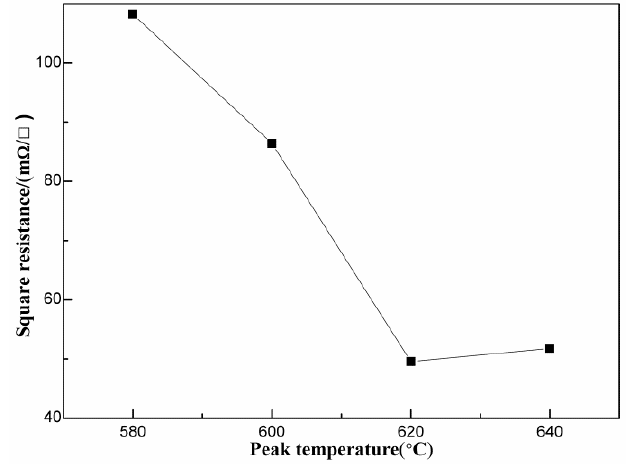
Figure 12. Square resistance curves of aluminum electrodes sintered with 4% sodium carbonate content at different peak temperatures from 580 °C to 640 °C.